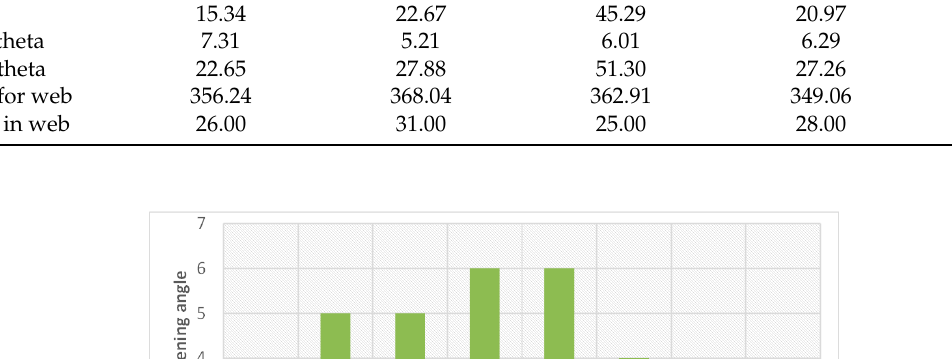
Table 1. Summary of measured angle ( θ ) of spider webs radials for five images.